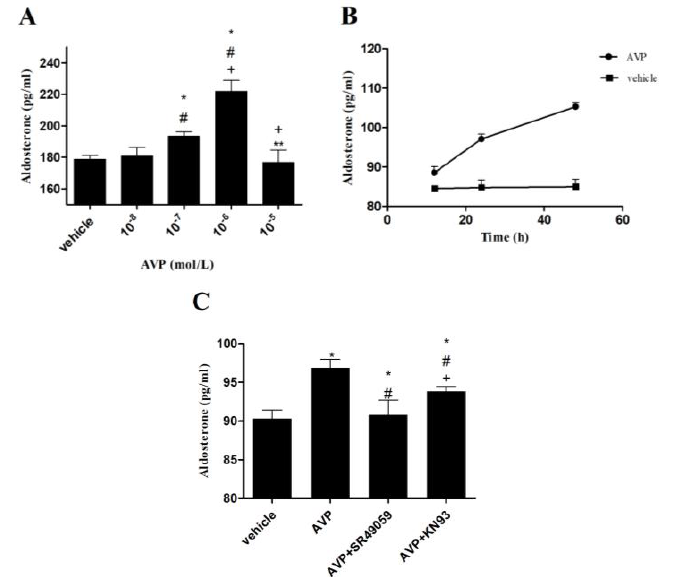
Figure 3. Effects of AVP on aldosterone secretion in CMECs. CMECs, cardiac microvascular endothelial cells; SR49059, AVP V1R antagonist; KN93, CaMK antagonist. ( A ) Effects of different concentrations of AVP on aldosterone secretion. * p < 0.05 vs. vehicle; # p < 0.05 vs. 10 −8 mol/L AVP; + p < 0.05 vs. 10 −7 mol/L AVP; ** p < 0.05 vs. 10 −6 mol/L AVP. ( B ) AVP (10 − 7 mol/L) time-independently induced secretion of aldosterone. ( C ) Effects of different antagonists on AVP-induced secretion of aldosterone. AVP, 10 −7 mol/L; SR49059, 10 −6 mol/L; KN93, 10 −7 mol/L. * p < 0.05 vs. vehicle; # p < 0.05 vs. AVP; + p < 0.05 vs. (AVP + SR49059).